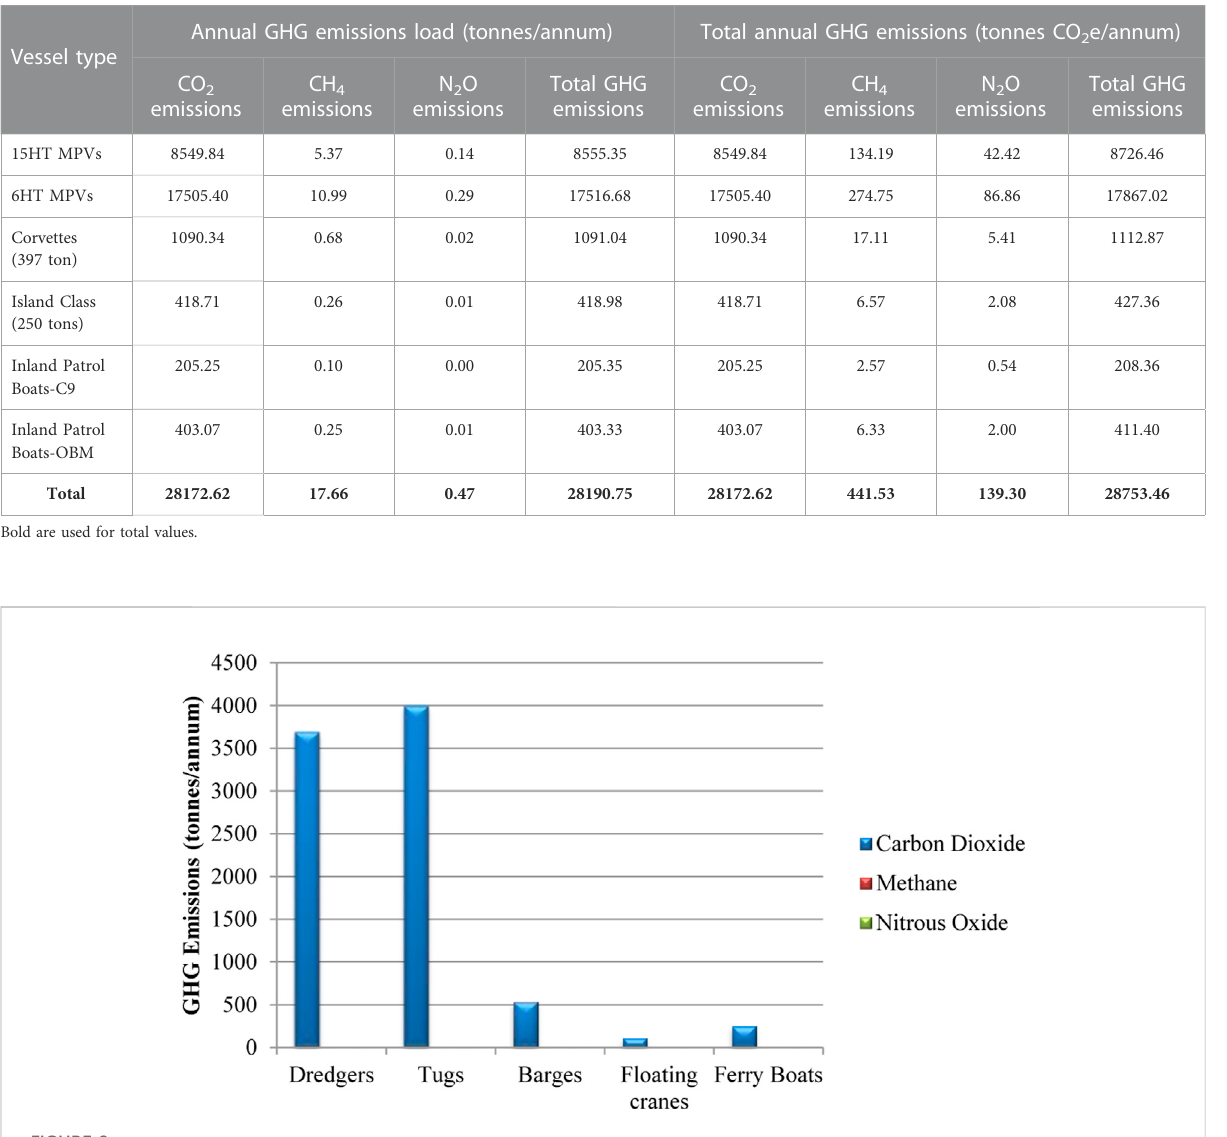
FIGURE 8 Breakdown of GHG emissions load from all types of harbour crafts of KPT.